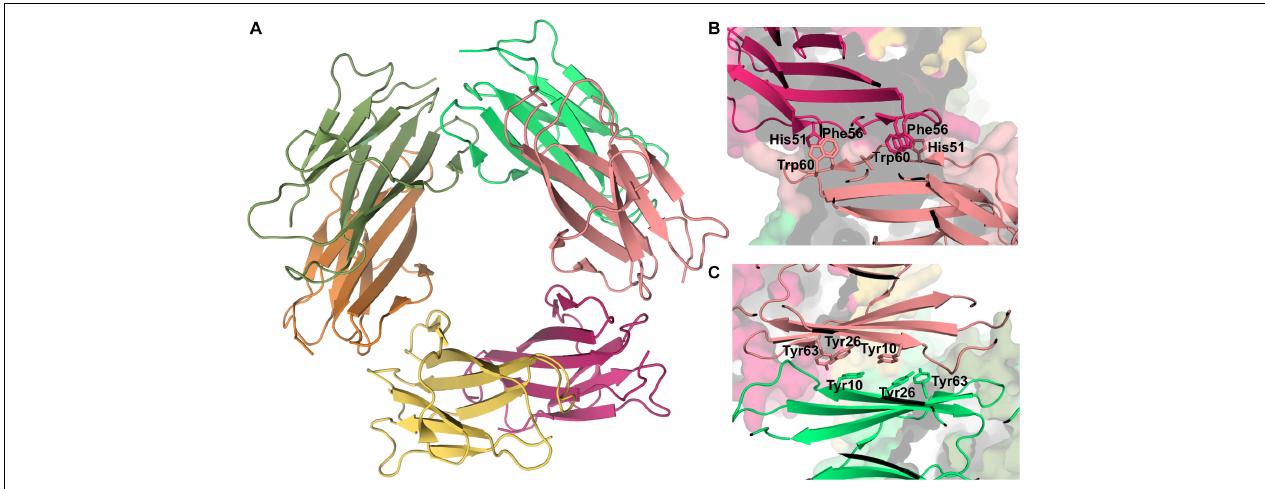
FIGURE 7 | Hexamer of β 2m. Three dimensional structure of the hexamer formed by the H13F mutant in the presence of Cu 2 + (PDB ID: 3CIQ) (A) . The hexamer results from the association of dimers that form an interface mediated by D-strands from adjacent chains stabilized by hydrogen bonds between Leu54, Asp34, and His31 (not shown) and hydrophobic interactions involving Phe56 and Trp60 from one chain and His51 and Asp34 from the other (B) . The other interface is mediated by the stacking of the ABED sheet from one chain onto the ABED sheet of an adjacent monomer in an antiparallel arrangement and stabilized by successive interactions involving Tyr residues (C)